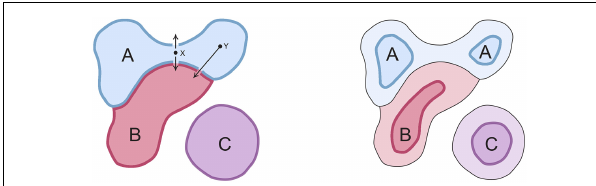
FIGURE 2 | How evolution acts to select the subset of SCs realized in real brains. Consider hypothetical domains A and B within whose boundaries the respective SCs evoke two distinguishable experiences, A and B . For SCs in real brains, and assuming SCs change location from generation to generation due to genetic and developmental variability, short trajectories that change or abolish an experience (e.g., X in the figure) are more likely to occur than longer ones (Y). Subjective experiences are therefore less robust in evolutionary terms when the SCs that evoke them are close to domain boundaries. Hence, over evolutionary time, the region within which point clouds are realized (bounded domains on the left hand diagram) will progressively shrink and separate from one another (right hand diagram) as the SCs in intervening regions of SC-space (paler colors) are eliminated from real brains. Domain C is included as a reminder that multiple domains can act together, as ensembles, so that, for example, experience A might only be evoked if both A and C (plus any number of additional domains) act in concert, or A and C might together evoke an entirely different